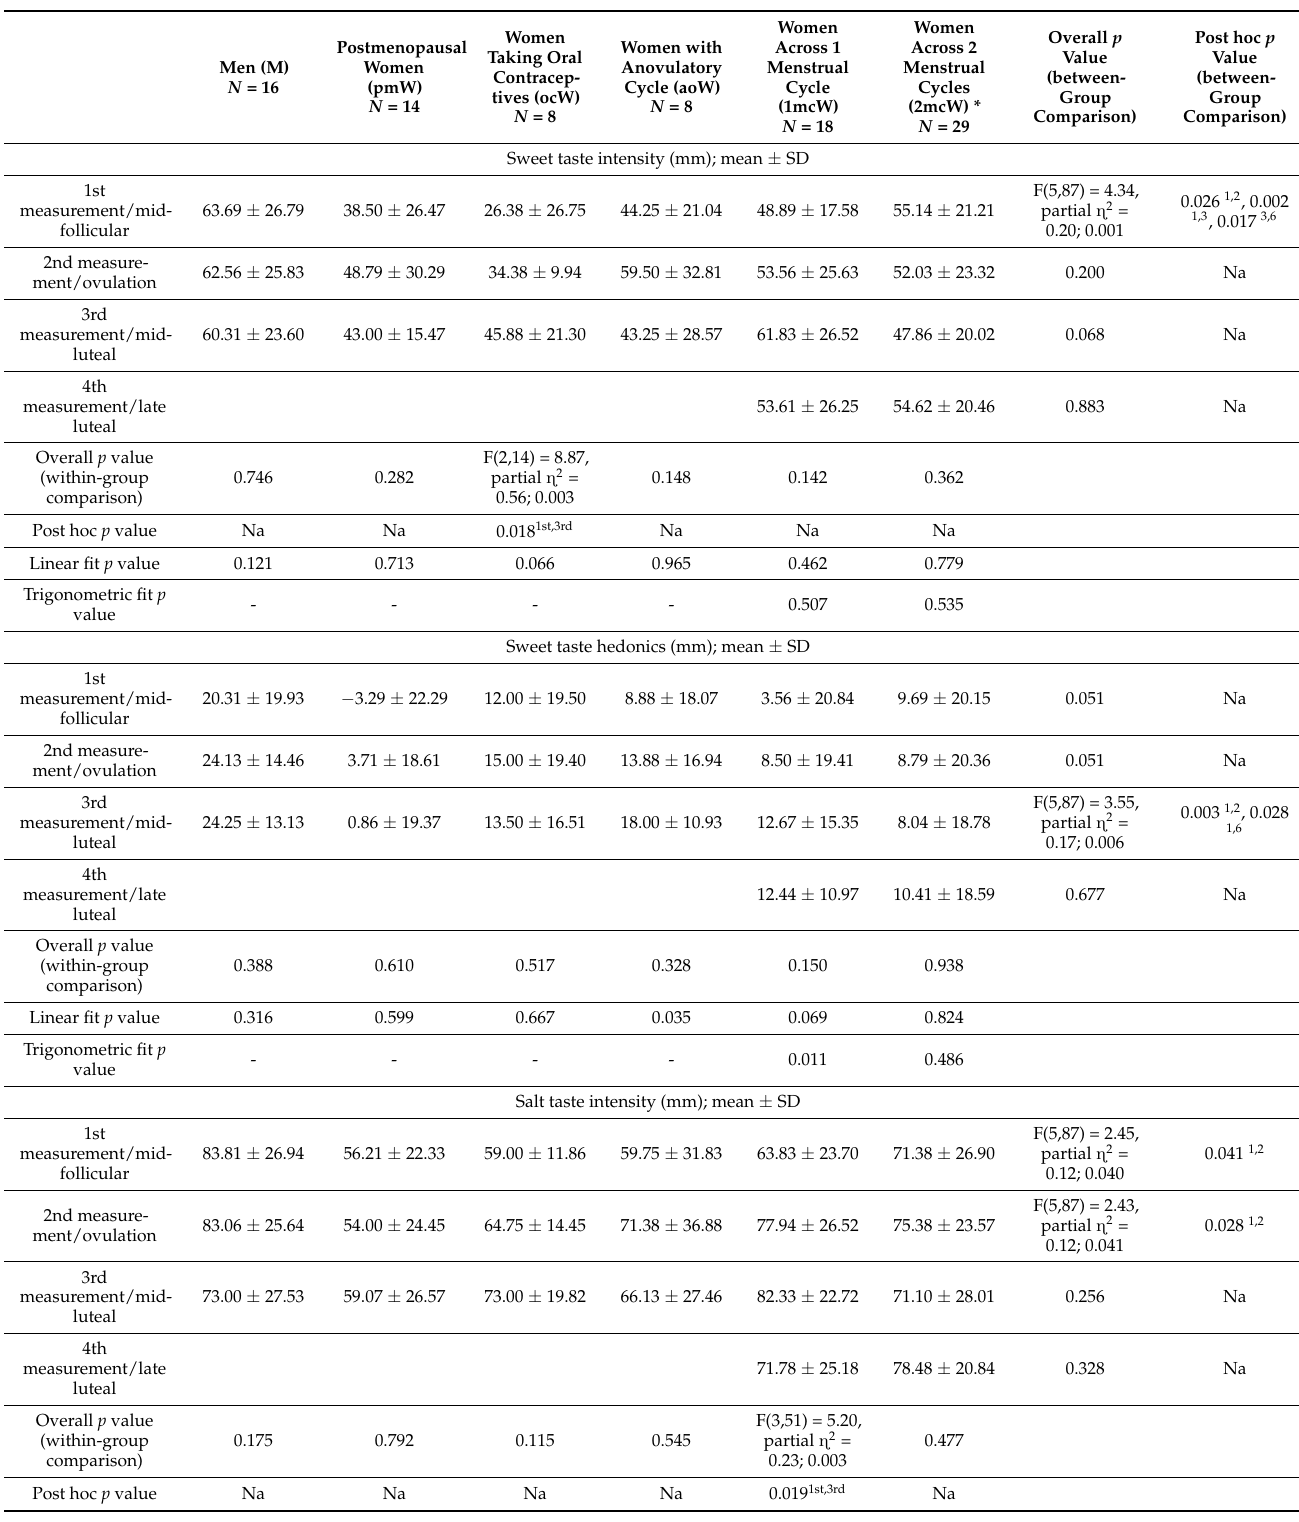
Table 4. Taste intensity and hedonic ratings for sweet (sucrose), salty (NaCl), sour (ascorbic acid), and bitter (quinine HCl) solutions in six groups of participants throughout measurement